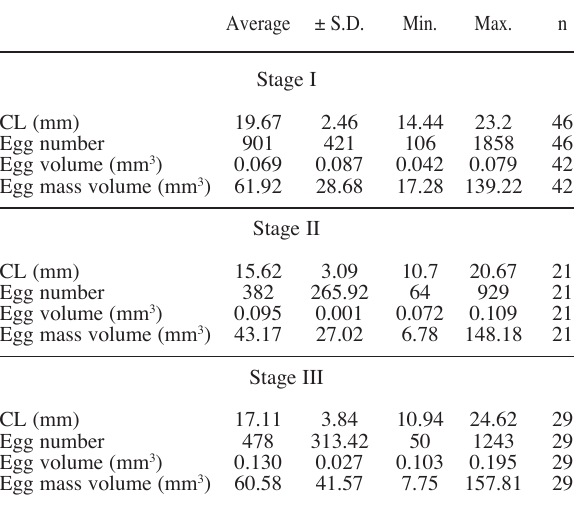
T ABLE 2. – Austropandalus grayi : size (CL) of ovigerous females, and clutch size, egg volume and brood mass during the incubation period; S.D. = standard deviation; n = number of observations.